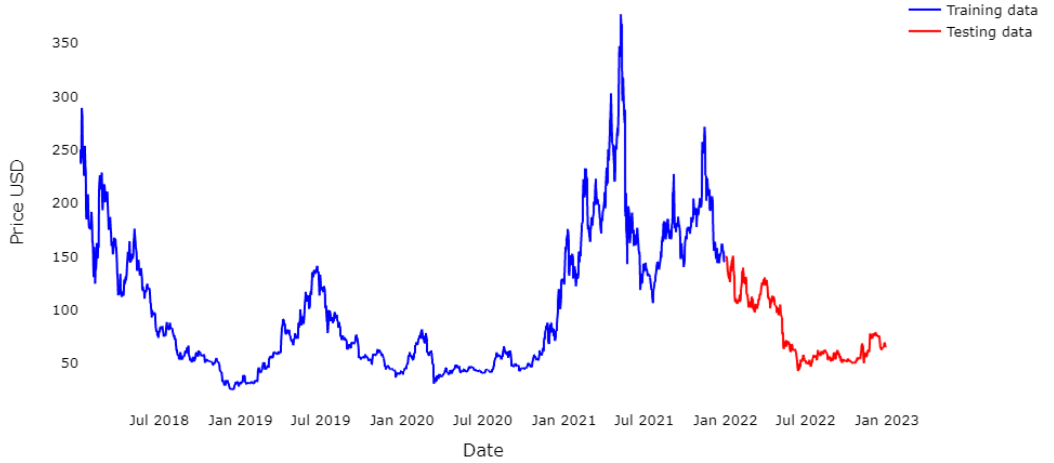
Figure 4. Training and Test samples for LTC.